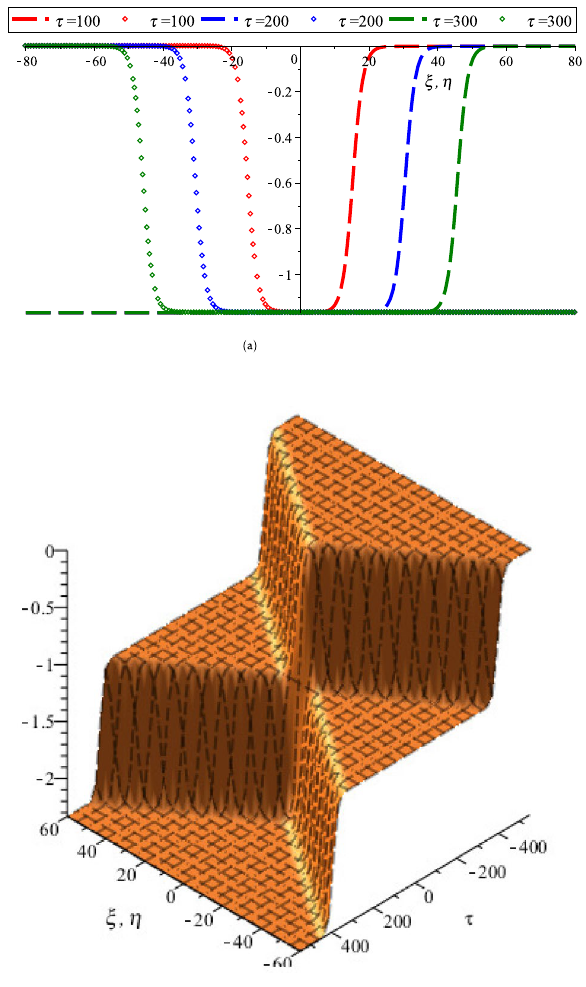
( 1 ) , τ) [Dashed dotted Figure 8. ( a ) Head-on collision between two equal amplitude DLs described by φ l (ξ ( 1 ) curves] and φ r (η , τ) [point curves] for different values of time and ( b ) 3D collisional shock wave structures ( 1 ) , τ) + φ ( 1 ) r (η , τ) for N of electrostatic potential φ l = φ l (ξ hc = 0.003 < K v with r = 0, q = 3.5, N ec = 0.4, σ = 3.5 and δ =